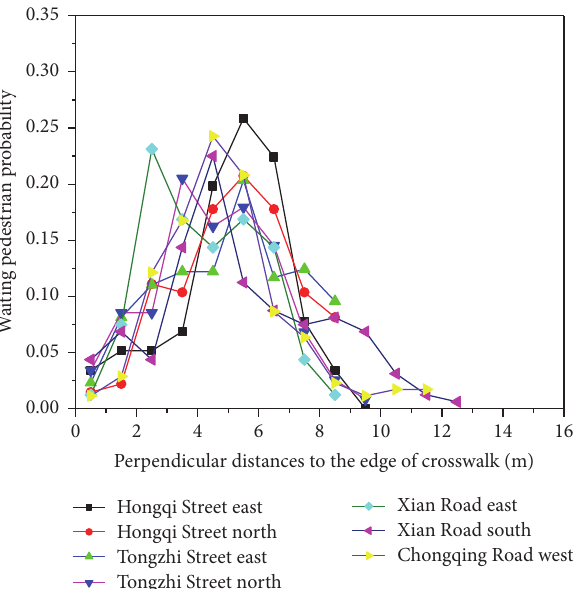
Figure 5: Observed and estimated pedestrian waiting positions.